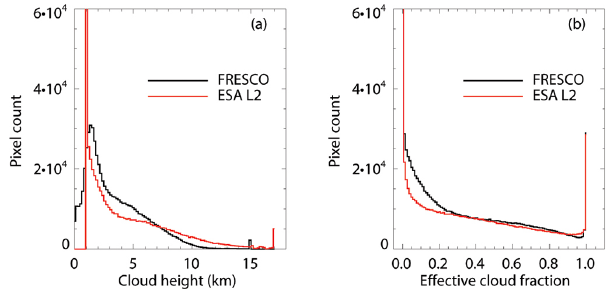
Figure 4. (a) Histogram of SCIAMACHY FRESCO cloud height and ESA L2 cloud top height for global data. (b) Histogram of SCIAMACHY FRESCO effective cloud fraction and ESA L2 cloud fraction. The pixel count for the ESA L2 product (out of range in the plots) is 1 . 6 × 10 5 at cloud height of 1km in (a) and is 2 . 0 × 10 5 at effective cloud fraction of 0.0 in (b)